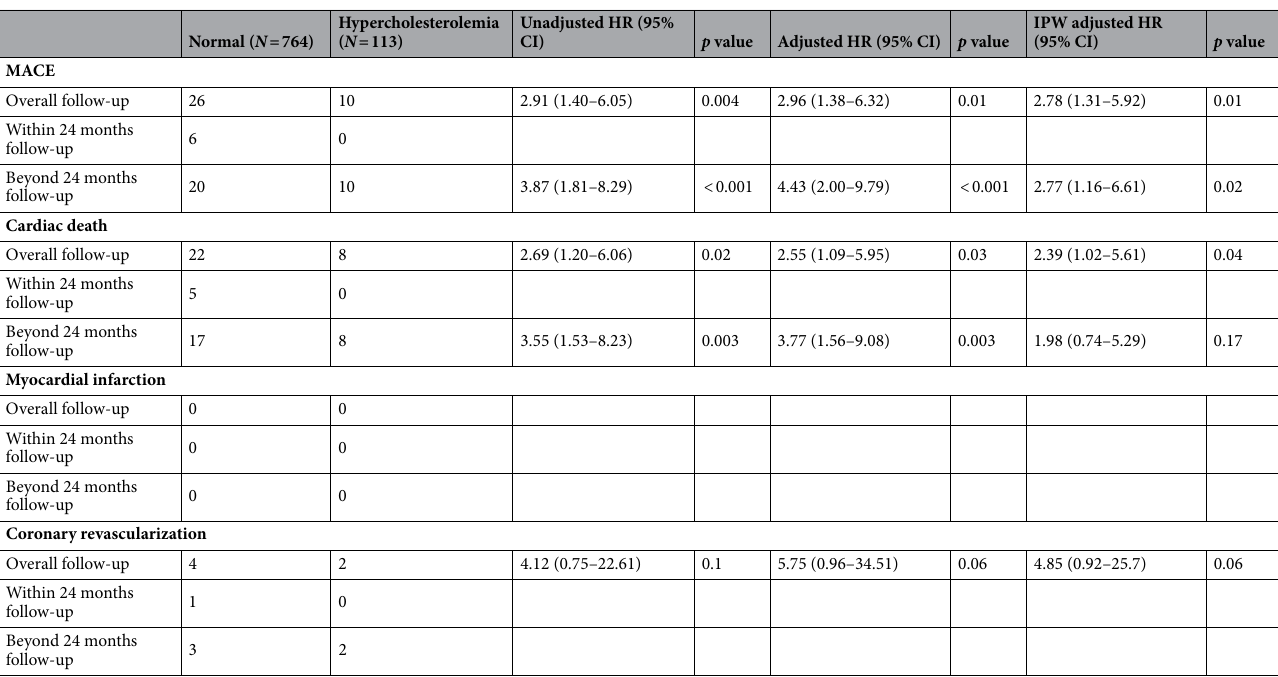
Table 2. Cardiovascular endpoints. Values are n (%), All analyses are others are based on the competing risk analysis. Covariates include male, age, hypertension, diabetes, tuberculosis, stroke, hepatocellular carcinoma, acute hepatic failure, and mTOR-based immunosuppression. MACE major adverse cardiac event, HR hazard ratio, IPW inverse probability weighting.